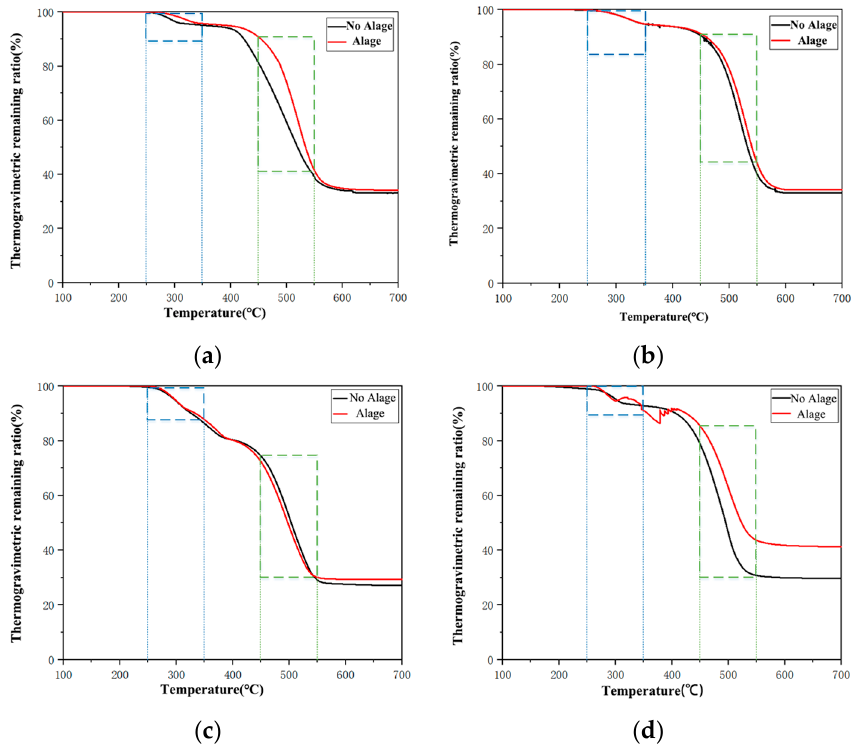
Figure 14. The thermogravimetric analysis of the RTV coatings. ( a ) 1 month. ( b ) 4 months. ( c ) 7 months. ( d ) 10